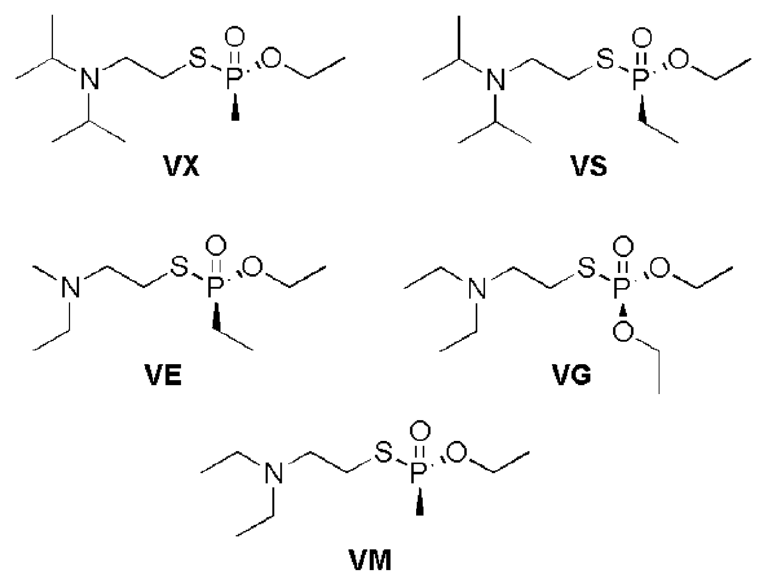
Figure 1. Chemical structures of studies V-type nerve agents .